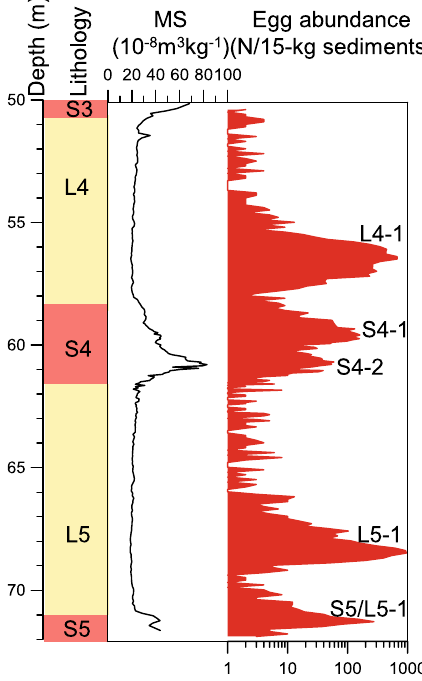
Figure 3. The depth, lithology, magnetic susceptibility (MS) and egg abundance from the L4, S4 and L5 units of the Huining loess–paleosol sequence. In the lithology column, the loess units (L4 and L5) are indicated by yellow shading and the paleosol units (the bottom of S3, entire S4 and upper S5) by red